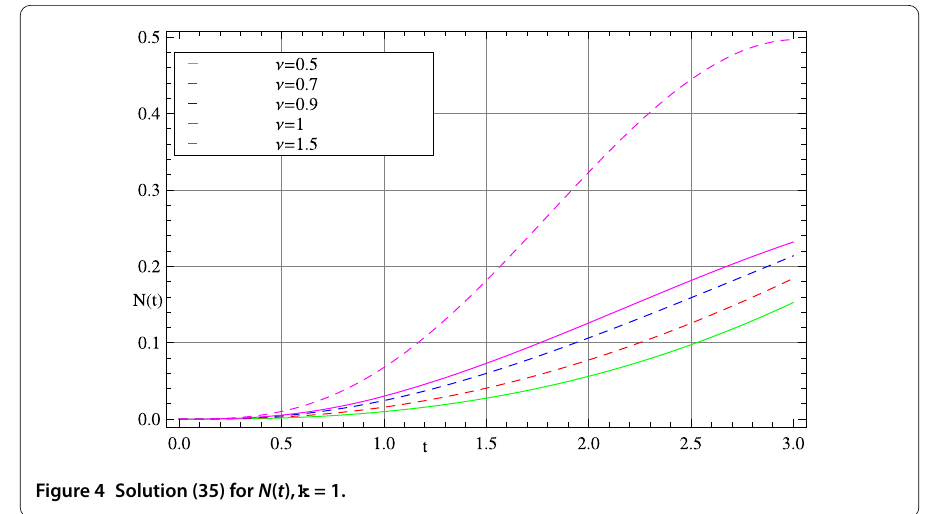
Figure 4 Solution (35) for N ( t ), k = 1.